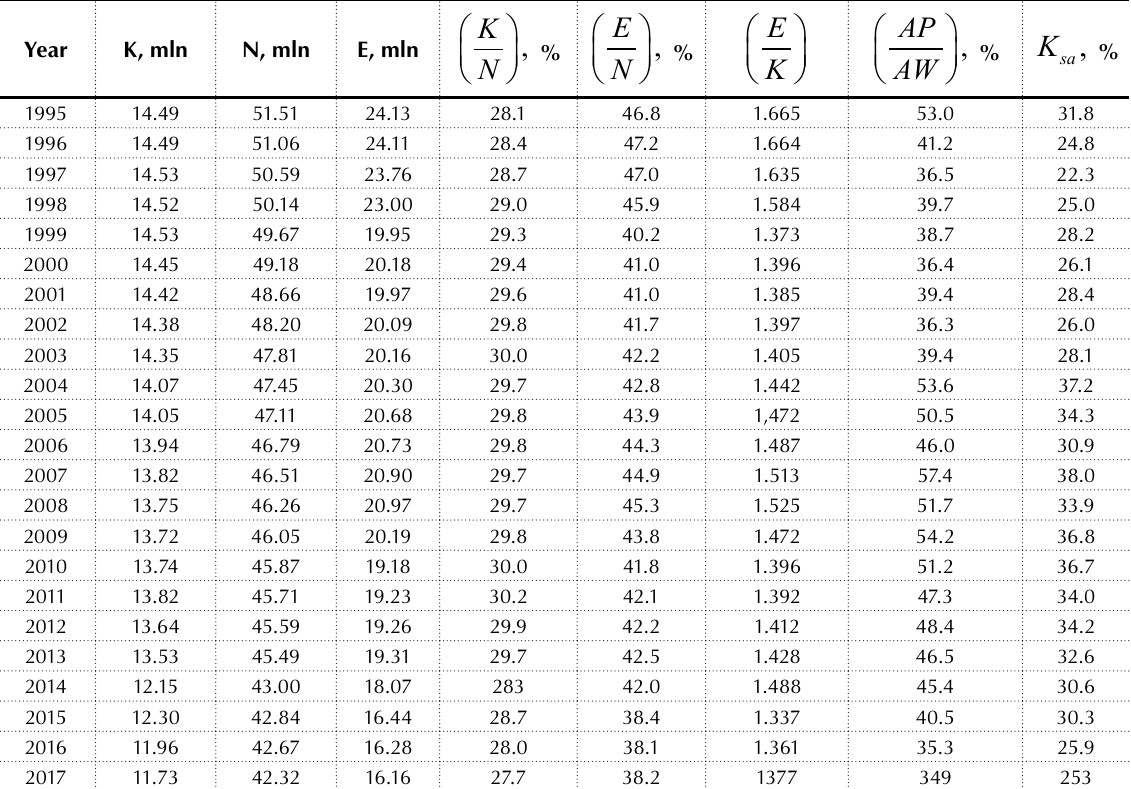
Table 1. Quantitative and relative indicators of Ukrainian pension system in 1995–2017 Source: State Statistics Service of Ukraine, authors’ calculations.